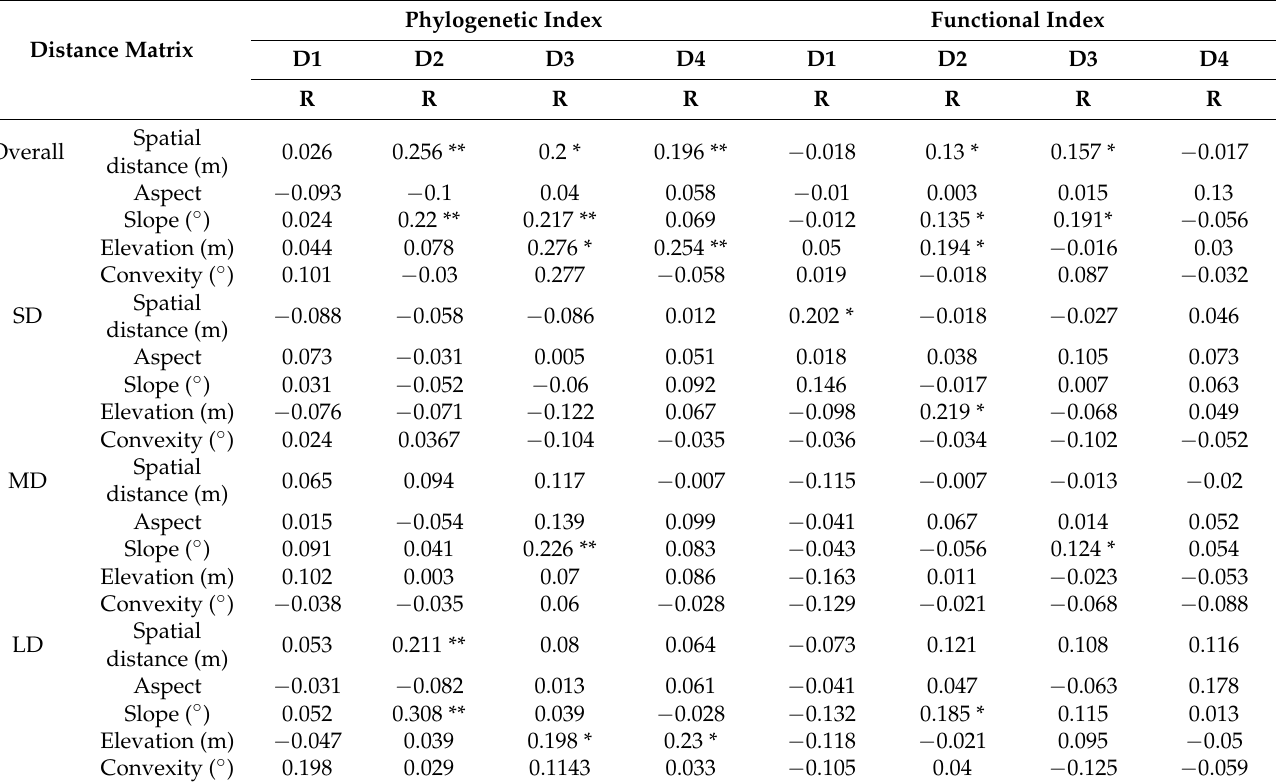
Table 6. Results of Mantel tests of the relationships between phylogenetic and functional structure with spatial and environment variables. D1, D2, D3, and D4 represent the plantation, twice-cut, once-cut, and old-growth forests, respectively. SD, MD, and LD represent small, medium, and large diameter classes, respectively. “*” and “**” represent p < 0.05 and p <